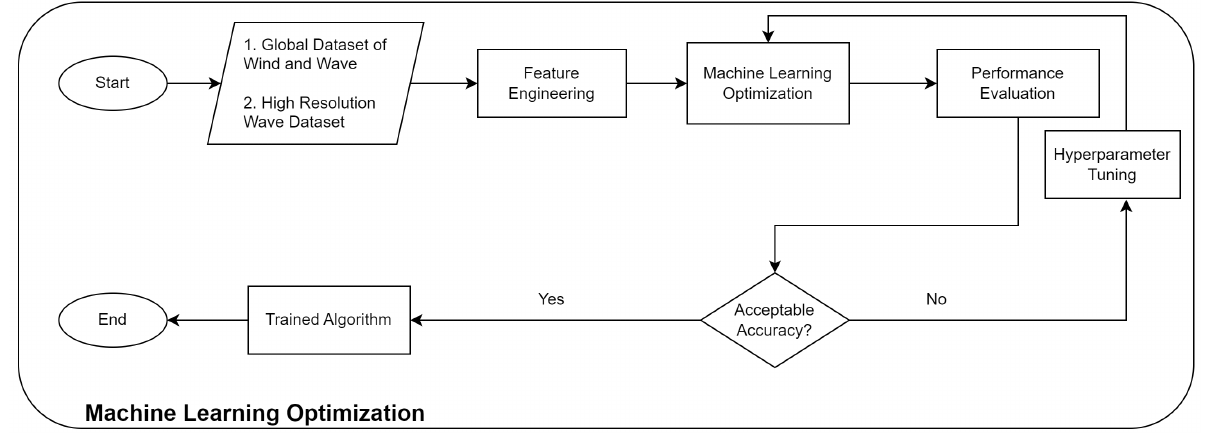
Figure 9. Flowchart of machine learning optimisation. The wave dataset from the previous step is used as training data for machine